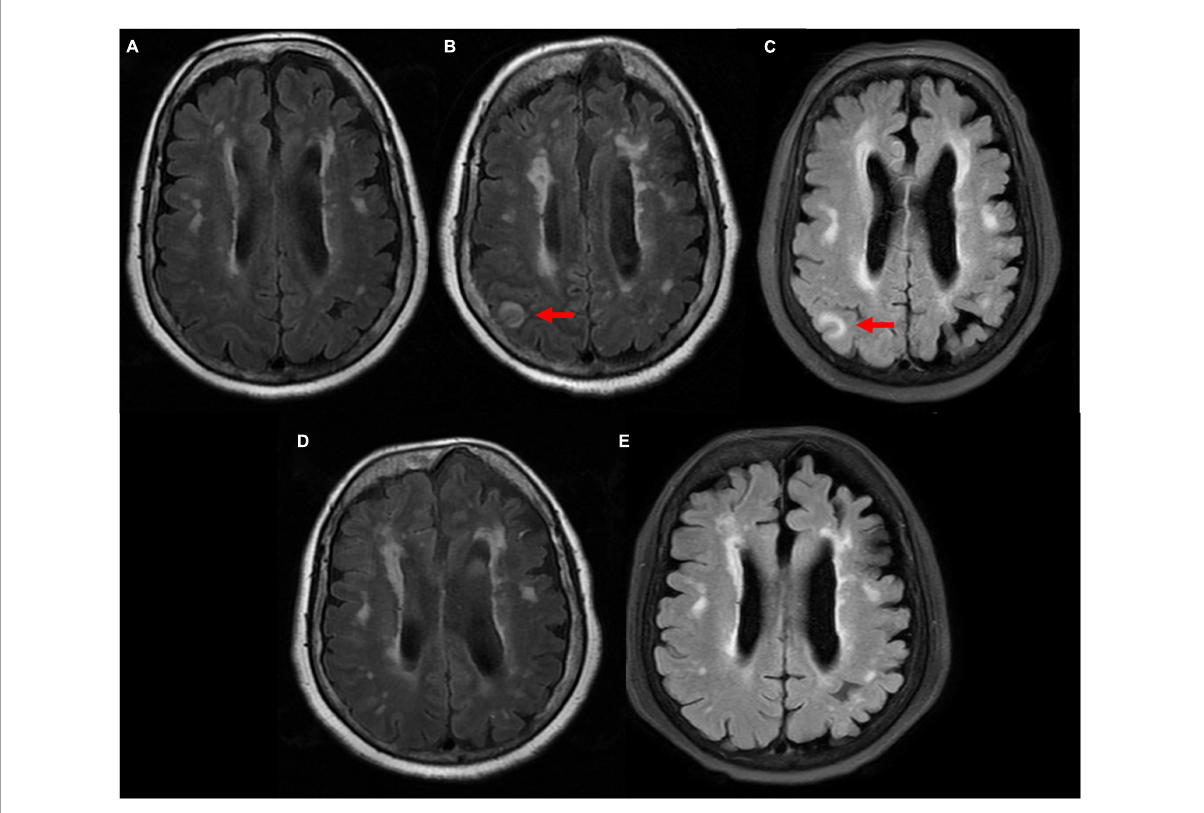
FIGURE2 Comparison of magnetic resonance imaging (MRI) T2 flair sequence. (A) 4 years ago patient suffered from moderate headache and performed MRI scan in our clinic department. It showed multiple ischemic infarcts, white matter degeneration, brain atrophy, with no sign of abnormal signal. (B) 24 h after neurological symptoms, right parietal and occipital cortex swelling with abnormal signals was observed. (C) 72 h after neurological symptoms, right parietal and occipital cortex swelling with abnormal signals remained. (D) 12 days after neurological symptoms, abnormal signals disappeared. (E) 50 days after neurological symptoms, no sign of new abnormal signal.